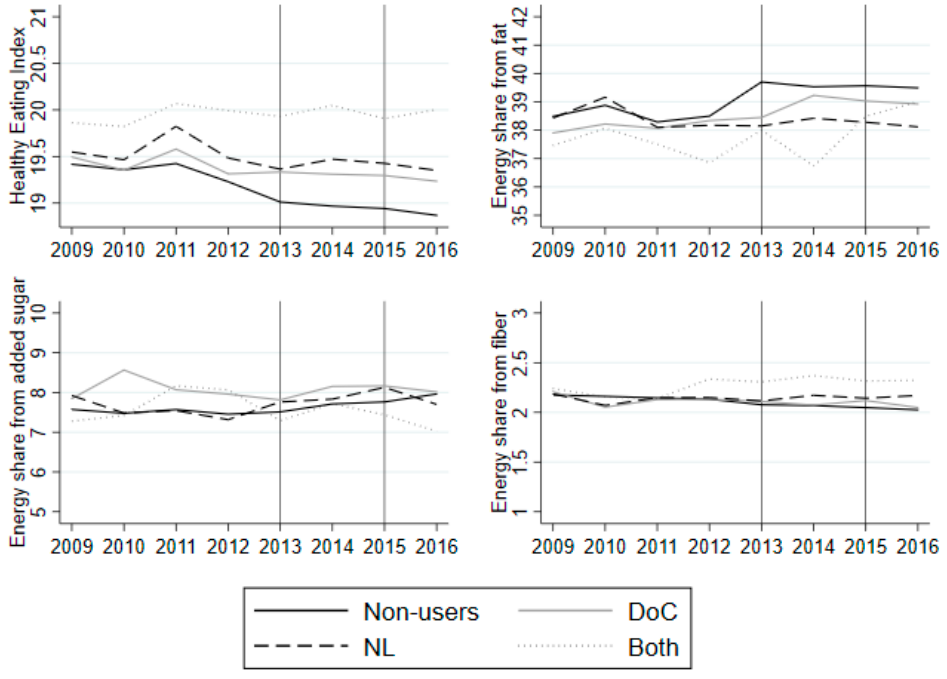
Figure 4. Average HEI and nutrient shares from 2009 to 2016 for NL switchers (dark grey dashed), DoC switchers (grey solid), Both switchers (light grey dotted), and non-users (black solid). Note: The vertical lines indicate the years in which the questionnaires were sent to the panel. The average is based on households that answered both questions on label use in 2013 and 2015. The averages are based on an unbalanced panel from 2009 to 2016, as not all of the household stay in the panel from 2009 to 2016.